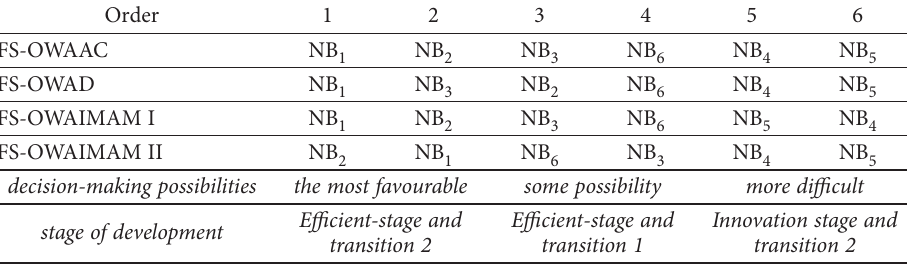
Table 12. Matrix ordering of alternatives Order 1 2 3 4 5 6